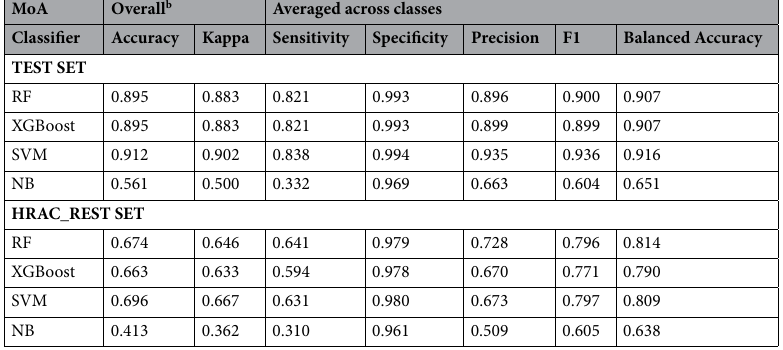
Table 2. Comparison of classification performance on the test and HRAC_REST case sets of the four optimized 16- class MoA ML models built in terms of 141 MACCS fp keys a . a Optimal values of classifiers’ hyperparameters are listed in Table S4. b The overall accuracy and kappa values are averaged over 10 × 10-fold CV resamplings.